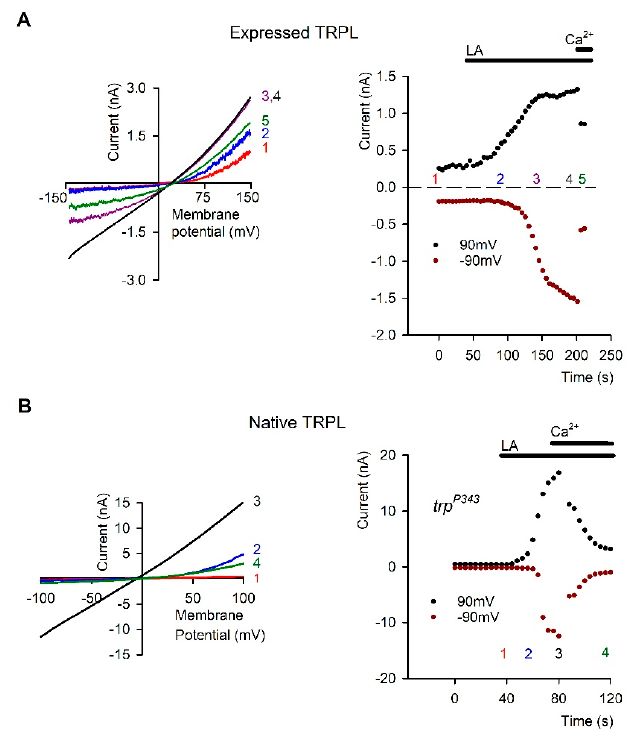
Figure 4. The action of Linoleic Acid (LA) is not mediated via PLC: ( A ) PLC activity was moni- Figure 4. Linoleic Acid (LA) removed Open Channel Block (OCB) from TRPL Channels: ( A ) Left , tored by using S2 cells expressing the Drosophila muscarinic receptor (DM1) and eGFP-PH, which binds to PIP 2 and IP 3 . Application of 50 μ M LA, under conditions which activated the channels, Representative I–V curves measured from S2 cells by whole cell patch clamp recordings using voltage did not elicit any change in the eGFP-PH distribution, as monitored by confocal images of the GFP ramps from − 150 mV to 150 mV in 1s. The typical outward rectification of the TRPL channels (red fluorescence (LA) relative to control. Application of carbachol (CCH) elicited a robust transloca- tion of eGFP-PH to the cytosol, which was reversed by CCH removal (wash), thus indicating acti- curve 1) was modified to a linear I–V curve after application of 40 µ M Linoleic Acid (LA, black vation of PLC ( n = 6). The relative fluorescence intensity at a cross section of the cell (marked by line) is also presented below the confocal images. The time course of the fluorescence changes curve 4). The effect at positive membrane potentials preceded that of negative membrane potentials measured in the cytosol is presented on the right. ( B ) Western blot analysis of head homogenates (Curves 2 and 3, blue and purple respectively, see also 1A right). Application of 5 mM Ca 2+ restored of dark raised WT and norpA p24 ;trp P343 double null mutant flies. Head membrane was extracted with SDS buffer and subjected to Western blot analysis with antibodies specific for the Drosophila the outward rectifying I–V curve (green curve 5). Right : The current values at 90 mV (black dots) proteins TRP, NORPA, and Dmoesin as indicated. No TRP and NORPA proteins were detected in the norpA p24 ;trp P343 double mutant. ( C ) Left : Representative I-V curves measured by whole cell re- and − 90 mV (dark red dots) are presented as a function of time. The numbers correspond to the cordings from photoreceptors of the norpA P24 ;trp P343 mutant lacking PLC and the TRP channel (see Figure 5B). In darkness, the TRPL channels are closed (red curve 1). The effect of the 60 μ M LA curves presented in the left ( n = 15). ( B ). Left , Representative I–V curves measured as in A from mutant was not altered by the absence of PLC and a linear I-V curve was obtained (black curve 4). The Drosophila ommatidia that express only TRPL channels ( trp P343 ). In darkness the TRPL channels were effect of LA at positive membrane potentials preceded that of negative membrane potentials (Curves 2 and 3, blue and purple, respectively) in a similar manner to the results of S2. Applica- closed (red curve 1). After application of 60 µ M LA, a linear I–V curve was obtained (black curve 3). tion of 10 mM Ca 2+ restored the outward rectifying I–V curve (green curve 5). Inset: enlargement of curves 1, 2, and 5, demonstrating more clearly the outward rectification. Right : the effect of LA on The effect of LA at positive membrane potentials preceded the effect at negative membrane potentials in a similar manner to expressed channels (blue curve 2). Application of 10 mM Ca 2+ blocked the TRPL channel (green curve 4, left), ruling out the possibility that the linear I–V curve was due to leak current. Right , the effect of LA on the current is presented as a function of time at 90 mV (black dots) and − 90 mV (dark red dots). The numbers correspond to the curves presented in the left ( n = 5). The I–V curve of the LIC is presented in pink (the maximal light intensity was attenuated by 2 log units). (From [78], Copyright 2000 Society for